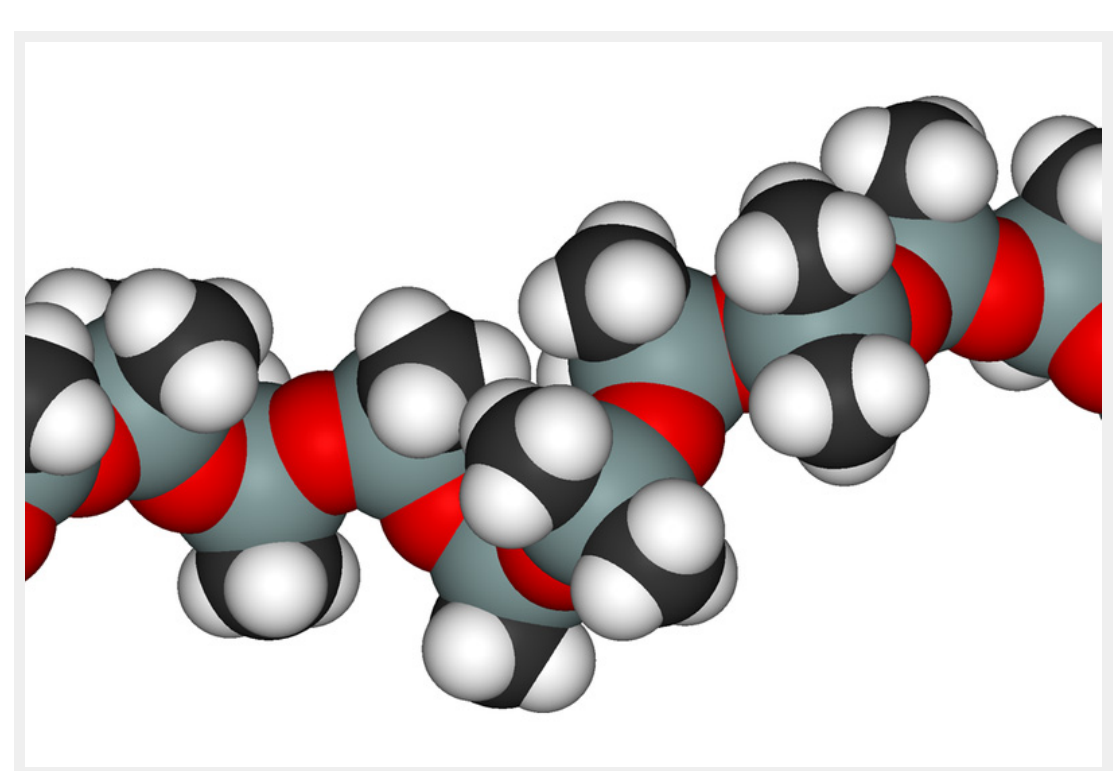
Figure 4 Three-dimensional representation of polydimethylsiloxane molecular structure. The large bond angles and bond lengths result in polymers which tend to be much more flexible and stretchable than rubbers with a carbon “backbone” – i.e. -C-C-C-. Source: Wikimedia